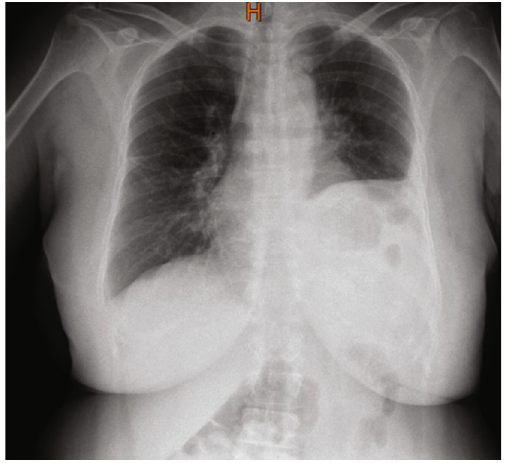
Figure 3: Cut section of the thyroid shows an ill-de fi ned creamy fi rm mass in the right